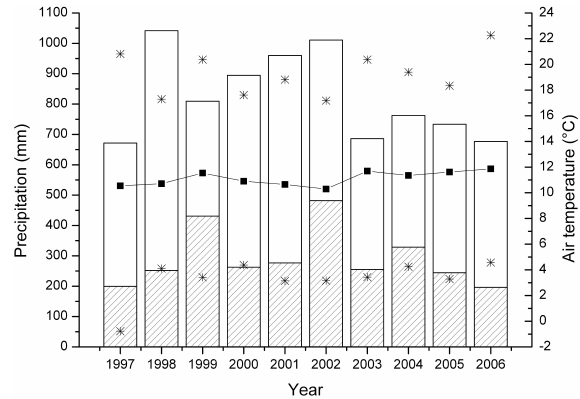
Fig. 1. Summary of the meteorological data measured on a 41m centrally located tower within the study site during the period from 1997 through 2006 (abscissa). The left ordinate axis displays yearly precipitation (mm) during the dormant season (dashed bar graph) and the growing season (open bars). The right ordinate displays av- erage yearly temperature ( ◦ C) (line graph: asterisks indicate lowest and highest mean monthly temperatures).